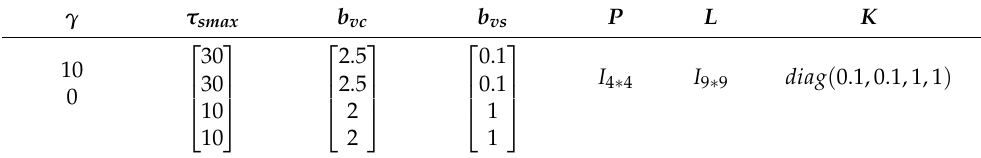
Table 4. Dynamic control